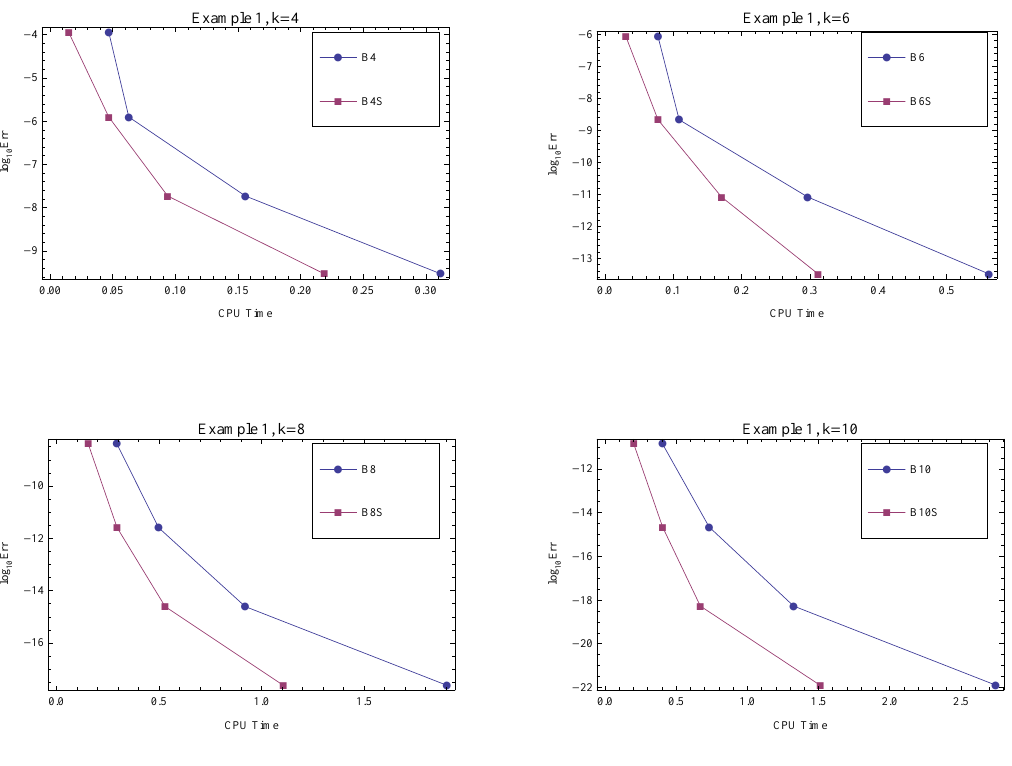
Figure 3. Efficiency curves for Example 1 comparing performances of usual